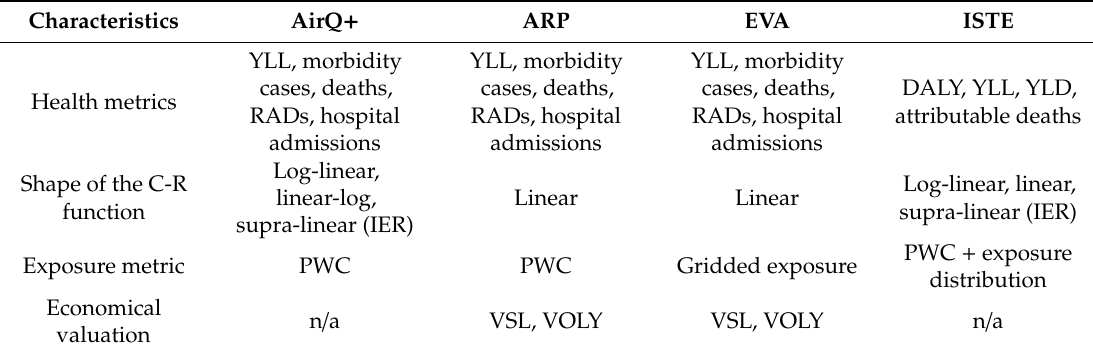
Table 1. Summary of the properties of the tools included in this work.